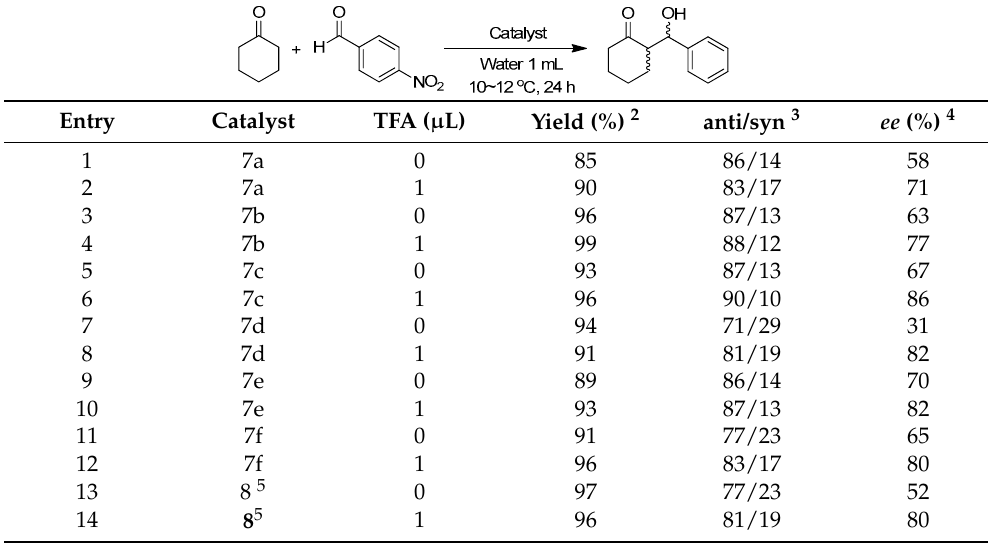
Table 4. Aldol reactions of cyclohexanone and p -nitrobenzaldehyde in water 1 .